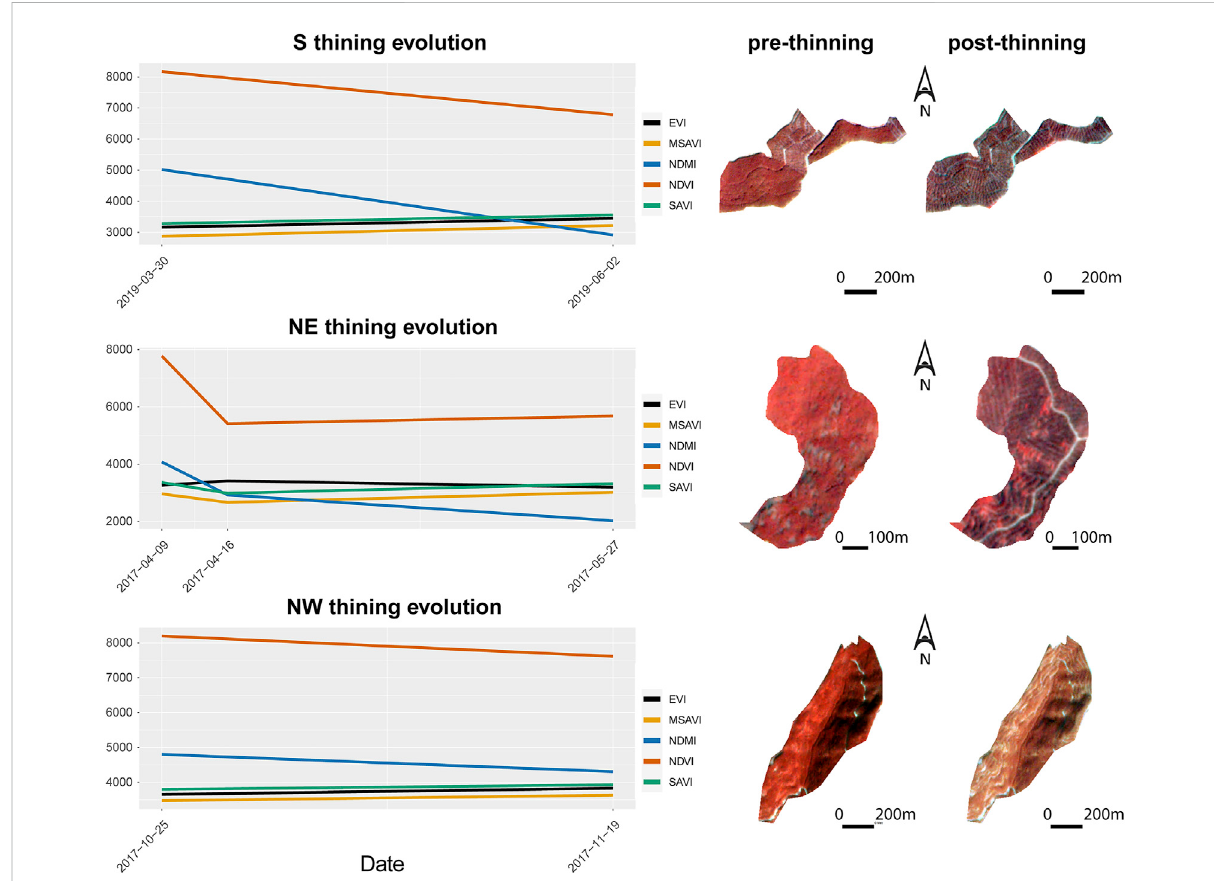
FIGURE 6 Enhanced vegetation index (EVI), normalized difference vegetation index (NDVI), normalized difference moisture index (NDMI), soil-adjusted